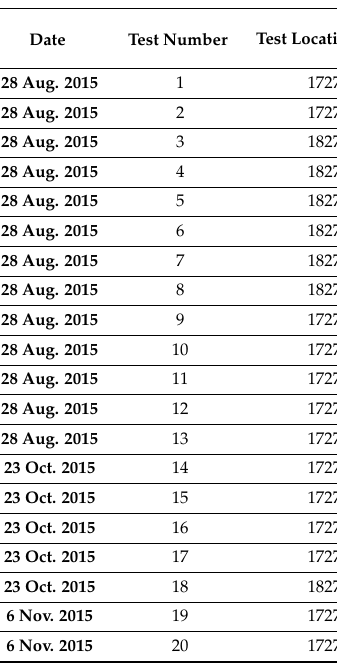
Table 1. Artificial discharge characteristics in the sewer network of Lykkjbekken,